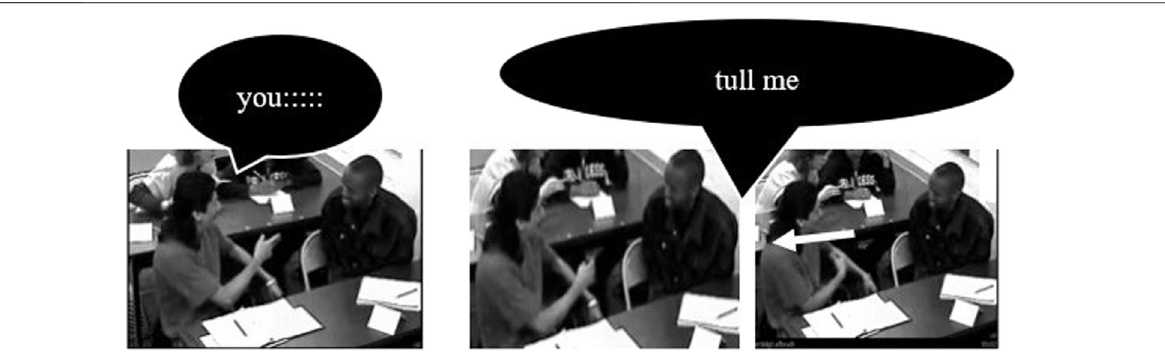
FIGURE 4 | Extract 2. line